Question: What kind of plot is shown here?
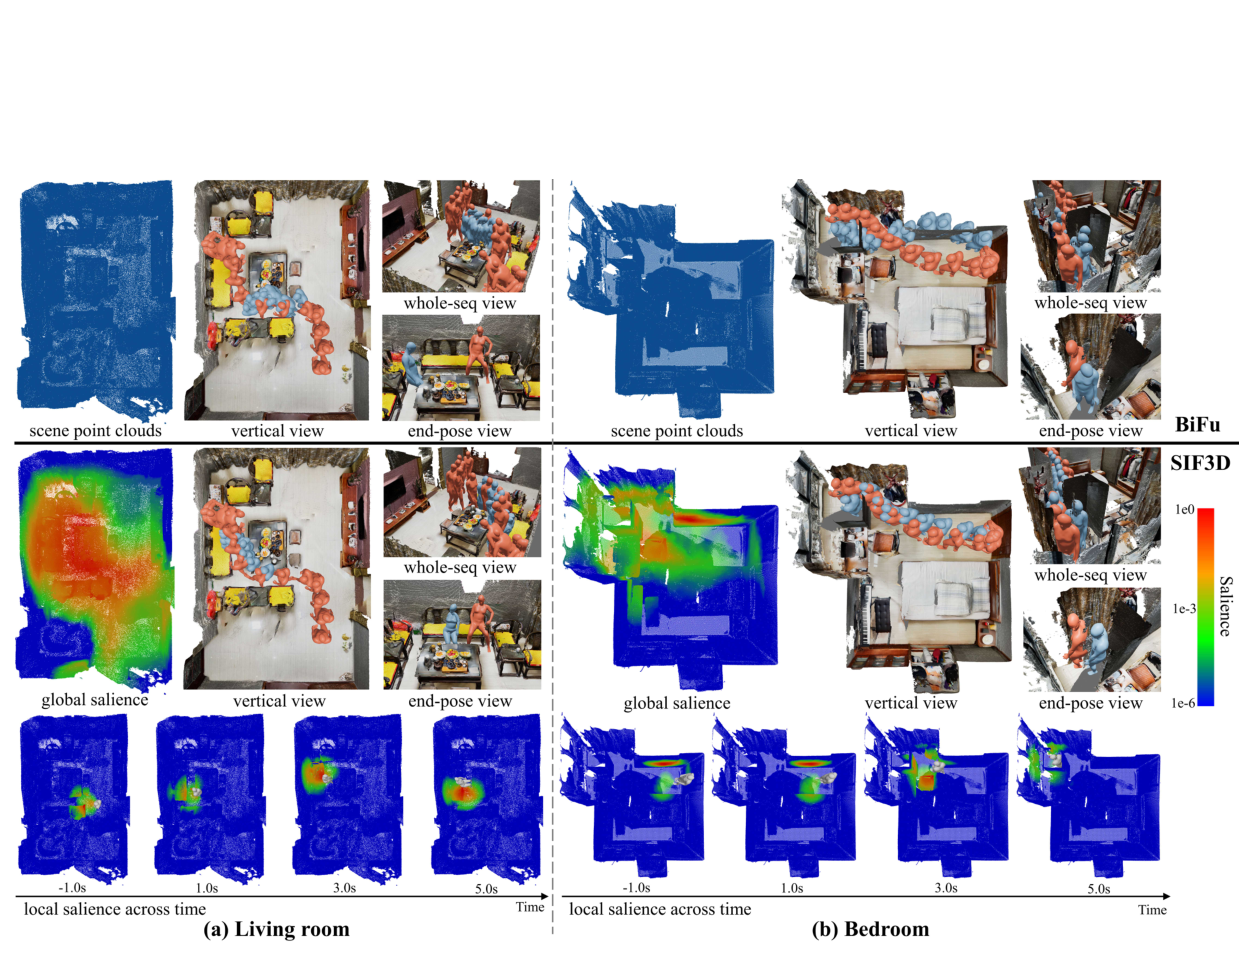
Answer: heatmap